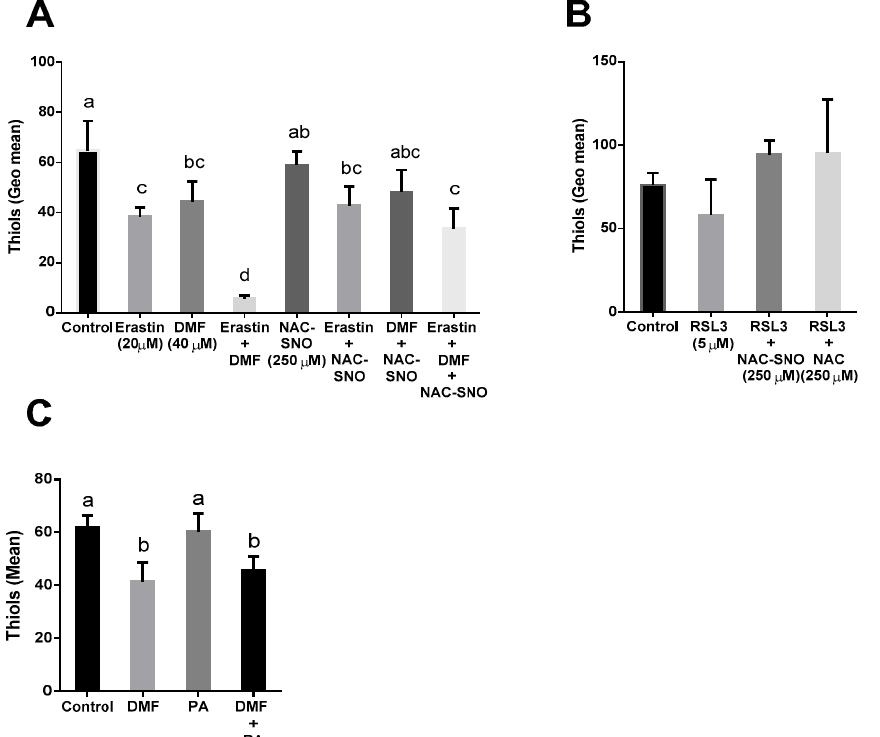
Figure 8. Thiols in lipotoxicity and ferroptosis . Thiols were measured with green CMFDA by FACS in AML12 treated with ( A ) Erastin (20 μ M), DMF (40 μ M), and NAC-SNO (250 μ M) for 6 h. ( B ) RSL3 (5 μ M), NAC-SNO (250 μ M), and NAC (250 μ M) for 6 h. ( C ) Pre-treated with DMF (40 μ M) for 6 h before palmitic acid (PA) (600 μ M) for another 6 h. Means with different letters are statistically dif- ferent ( p < 0.05).